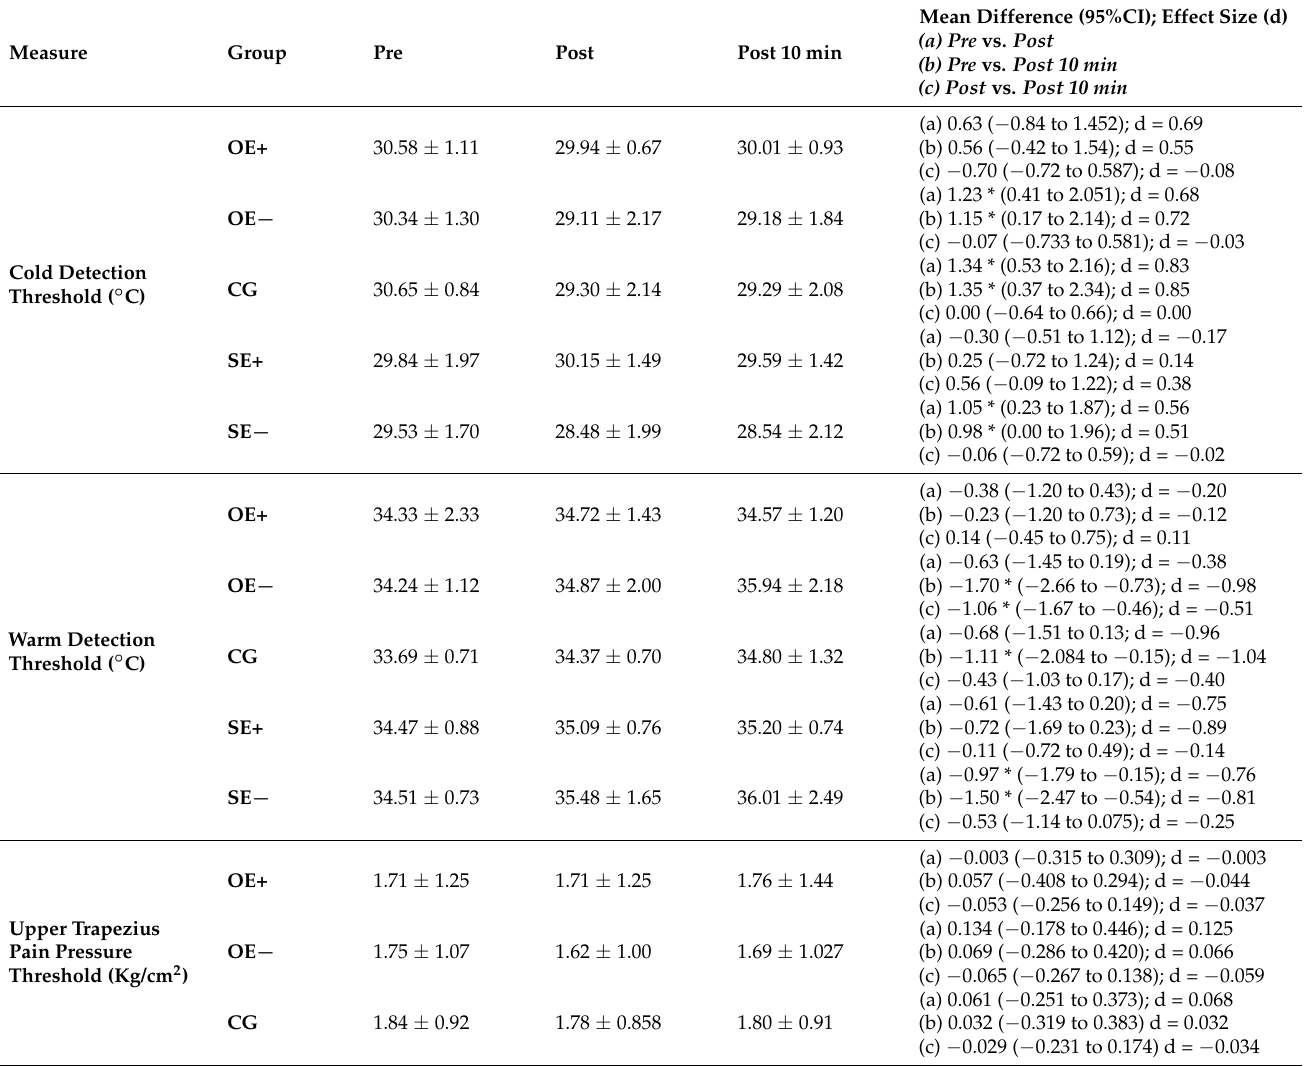
Table 2. Within-group comparisons of CDT, WDT and proximal PPT during mental representa- tion